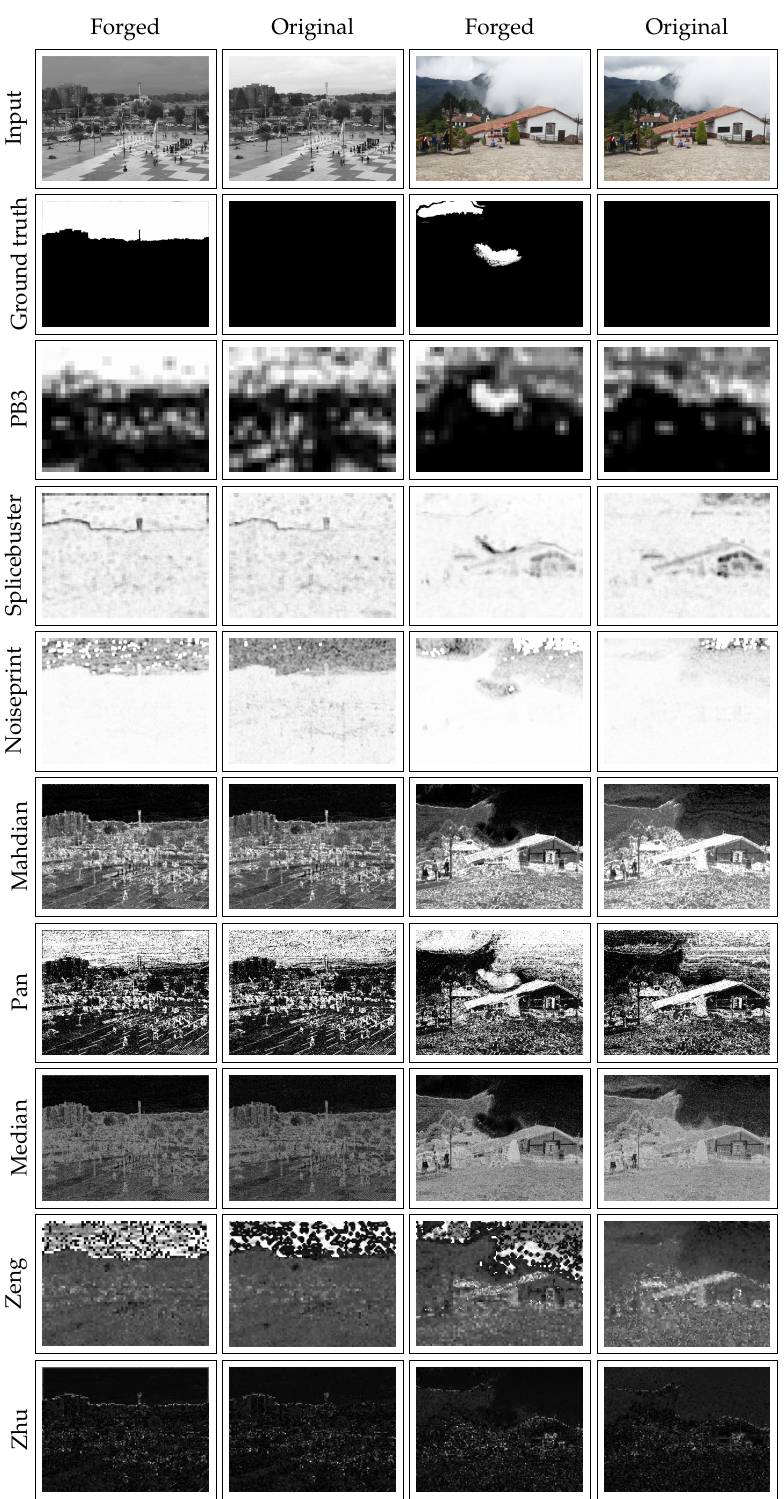
Figure 6. Results obtained for examples where colorization ( first column ) and retouching ( third column ) were performed, as well as for their corresponding original images ( second and fourth columns ). On the successive rows, the results obtained by each of the approaches for these